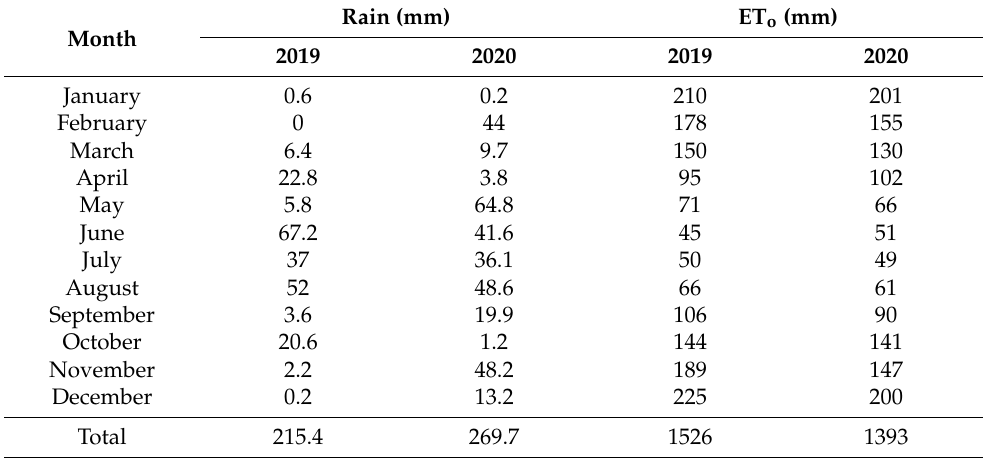
Table 2. Total monthly rainfall (mm) and reference evapotranspiration (ET o ) for 2019 and 2020. Rain (mm) ET o Month